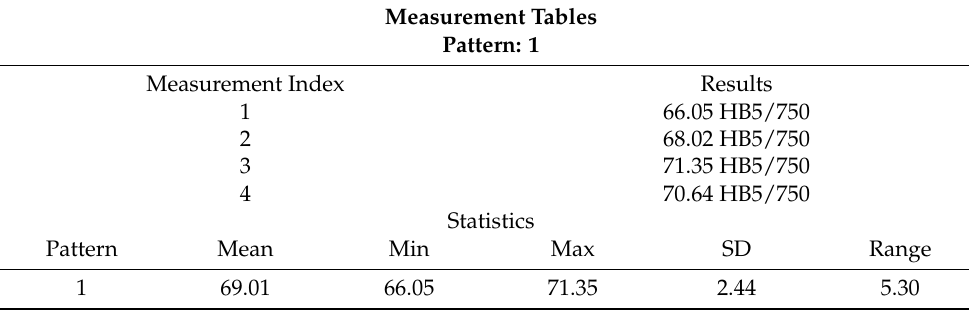
Table 3. Standard deviation (SD), statistics, and pre-cut hardness readings.